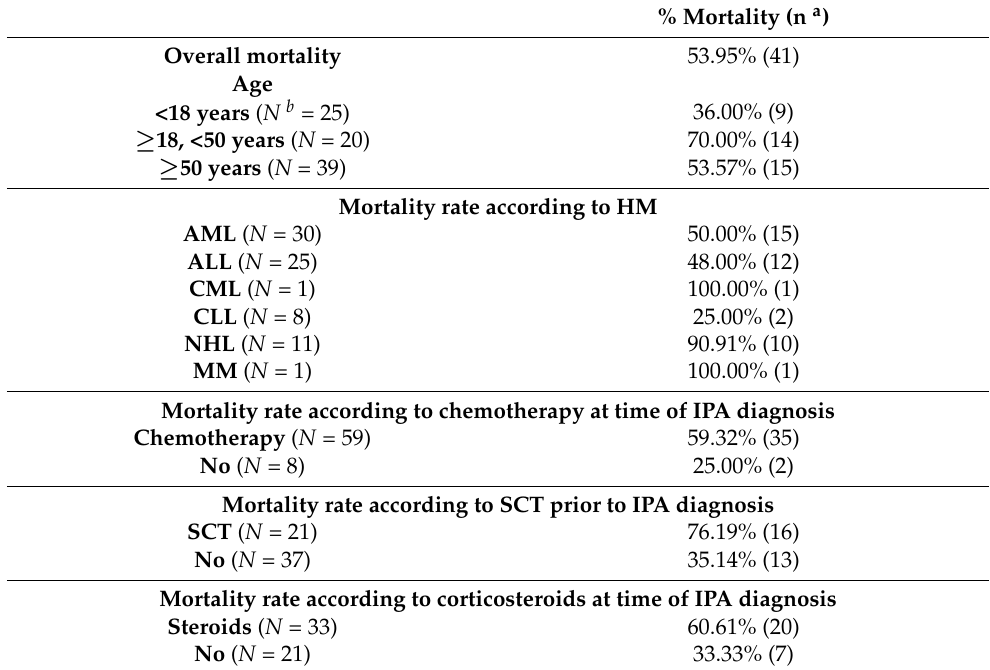
Table 9. Potential factors associated with